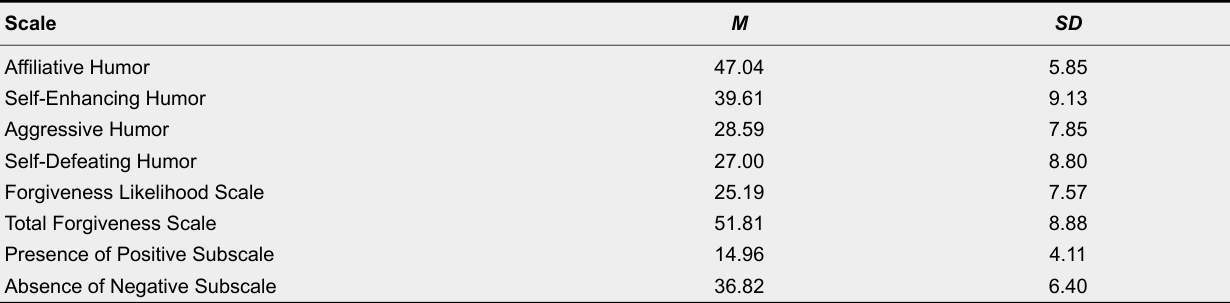
Means and Standard Deviations for the Four Humor Styles, the Forgiveness Likelihood Scale, the Total Forgiveness Scale, and Absence of Negative and Presence of Positive Subscales of the Forgiveness Scale